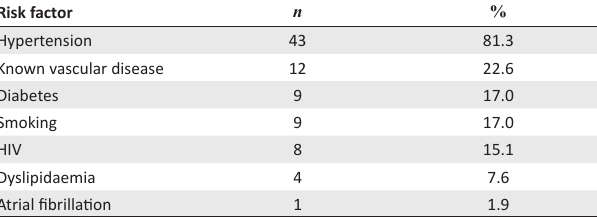
TABLE 1: Frequency of pre-existing risk factors for stroke ( N =